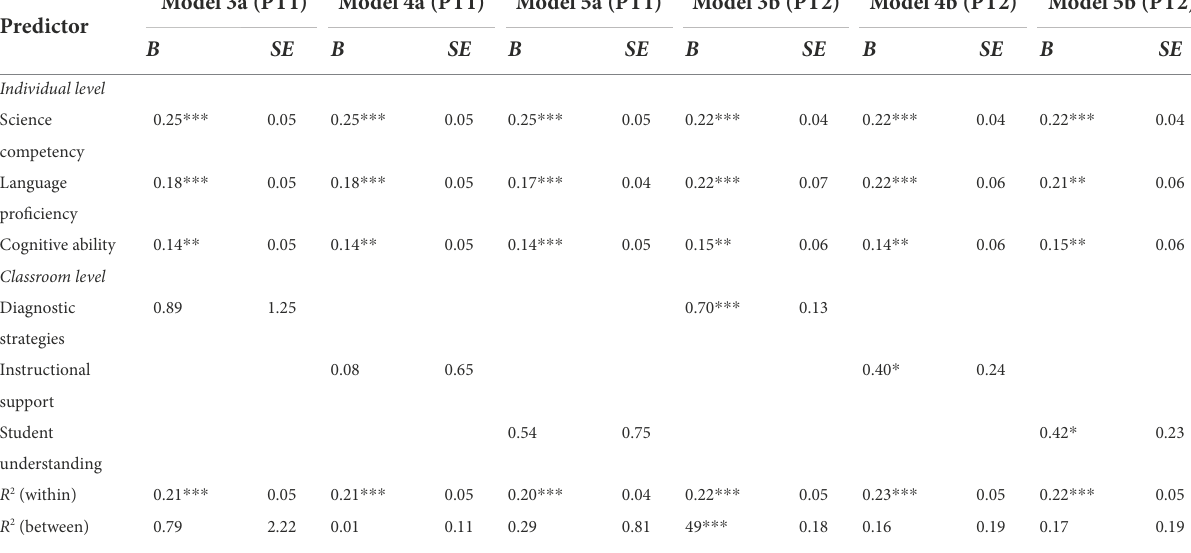
TABLE 5 Multilevel regression analyses predicting student performance on the posttests from individual-level variables and three indices of adaptive classroom discourse.